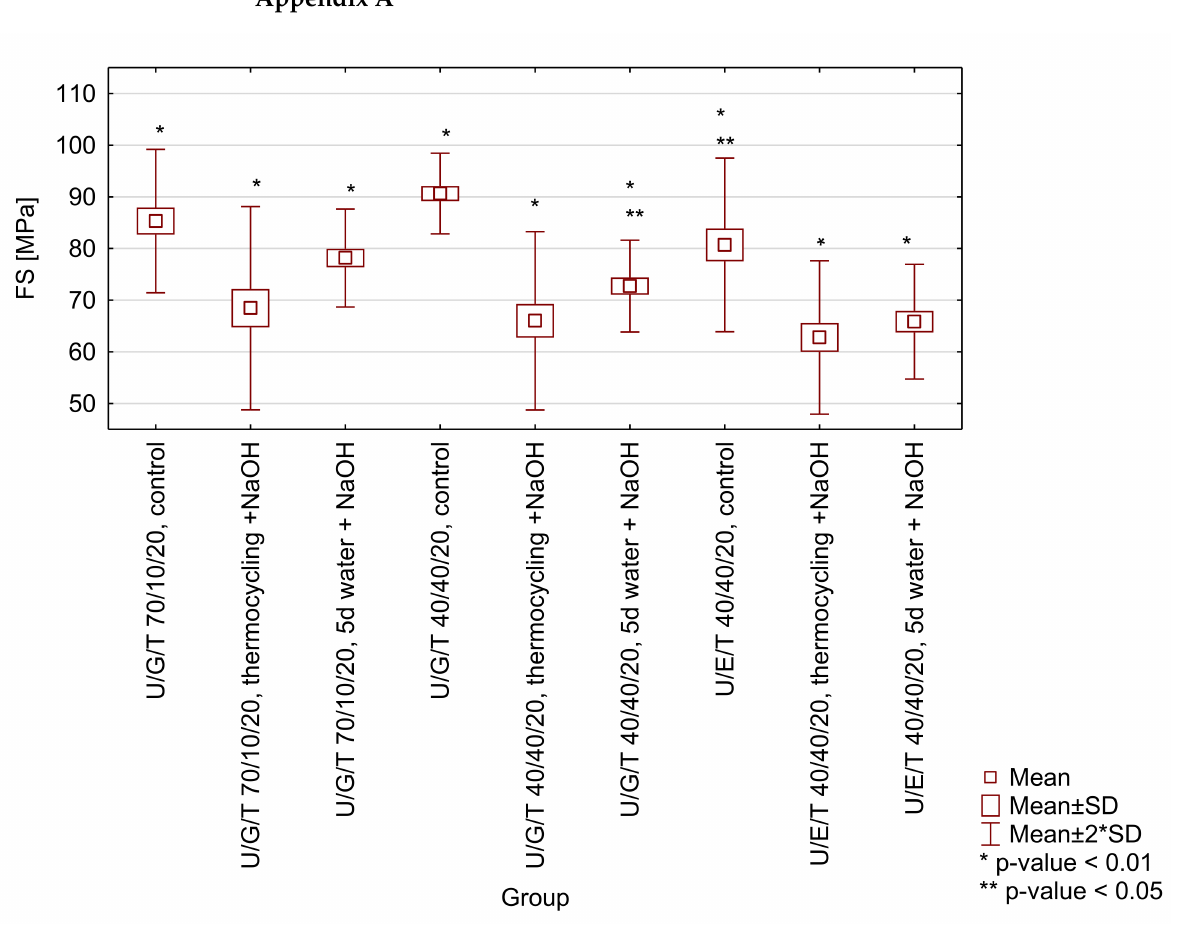
Figure A1. Box-and-whisker plot of three-point bending flexural strength (FS) of tested matrices (UDMA/Bis-GMA/TEGDMA 70/10/20 wt.% and 40/40/20 wt.% and UDMA/Bis-EMA/TEGDMA 40/40/20 wt.%) after selected ageing protocols (control-water, 24 h, 37 ◦ C; thermocycling + NaOH- water, 7500 thermo cycles, 5/55 ◦ C and 0.1 M NaOH, 7 days, 60 ◦ C; 5 d water + NaOH-water, 5 days, 55 ◦ C and 0.1 M NaOH, 7 days). Significant differences occur in a given group with a probability of p < 0.01 (*) and/or p < 0.05